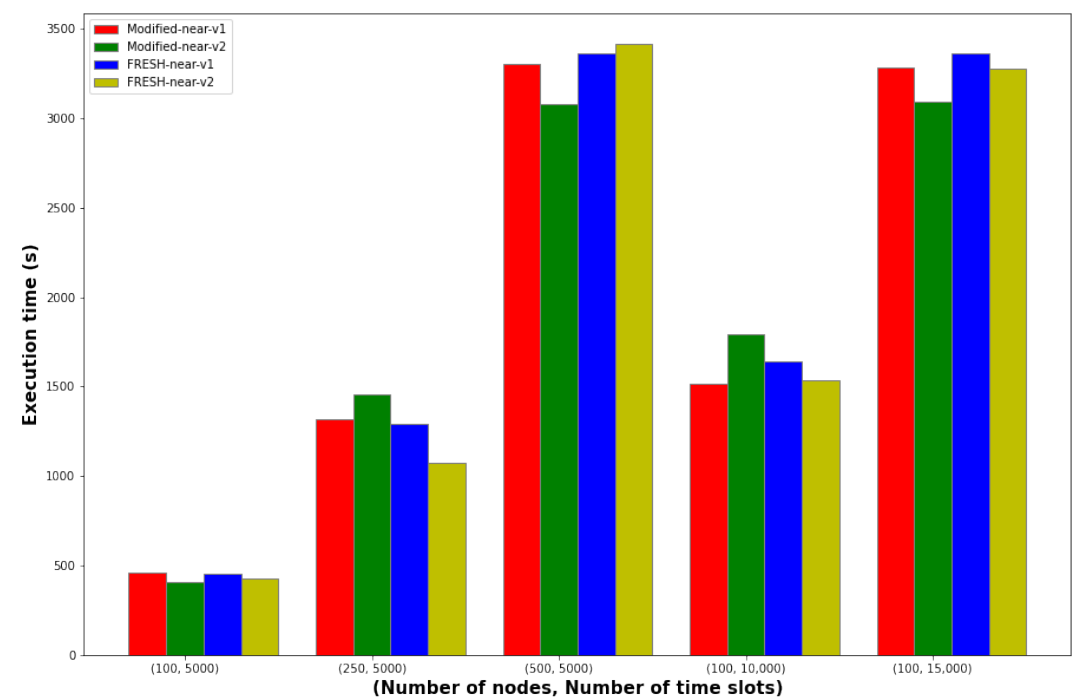
Figure 11. Running time of simulations for various values of system parameters for Modified-near-v1, Modified-near-v2, FRESH-near-v1 and FRESH-near-v2